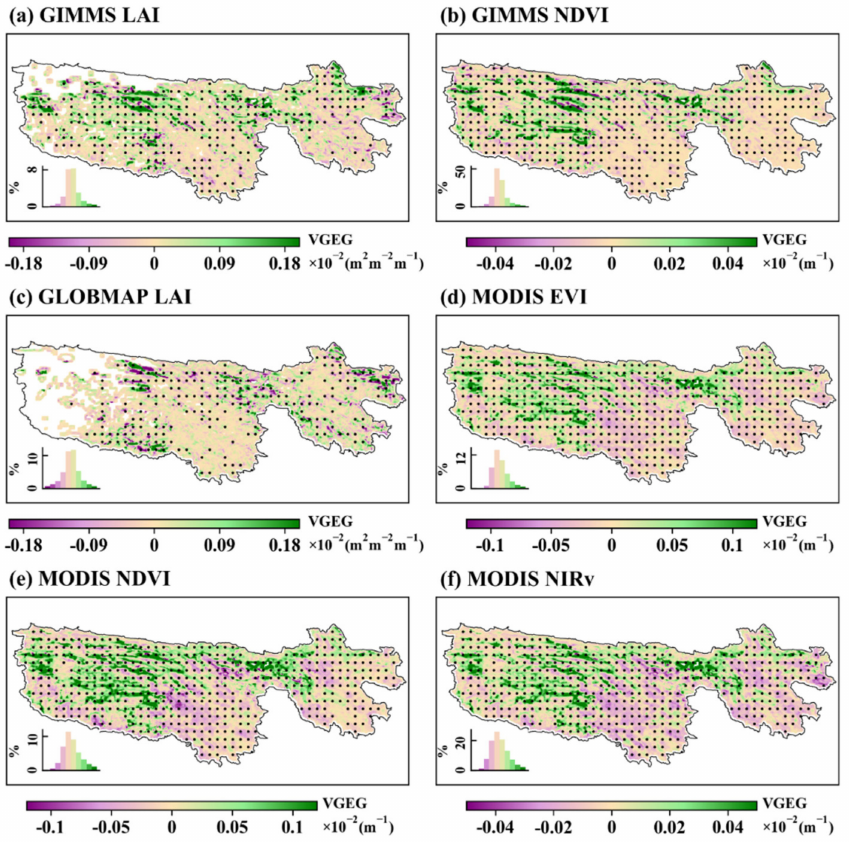
Figure 7. Spatial pattern of the mean VGEG (Vegetation Greenness along the Elevation Gradient) from 2001 to 2016. ( a ): Global Inventory Modeling and Mapping Studies leaf area index (GIMMS LAI); ( b ): GIMMS Normalized Difference Vegetation Index (NDVI); ( c ): Global Mapping (GLOBMAP) LAI; ( d ): Moderate Resolution Imaging Spectroradiometer Enhanced VI (MODIS EVI); ( e ): MODIS NDVI; ( f ): MODIS near-infrared reflectance of vegetation (NIRv). The value frequencies are shown in the bottom left inset for each panel. The regions marked with black dots (generated by 9 × 9 windows) indicate statistical significance at the 0.05